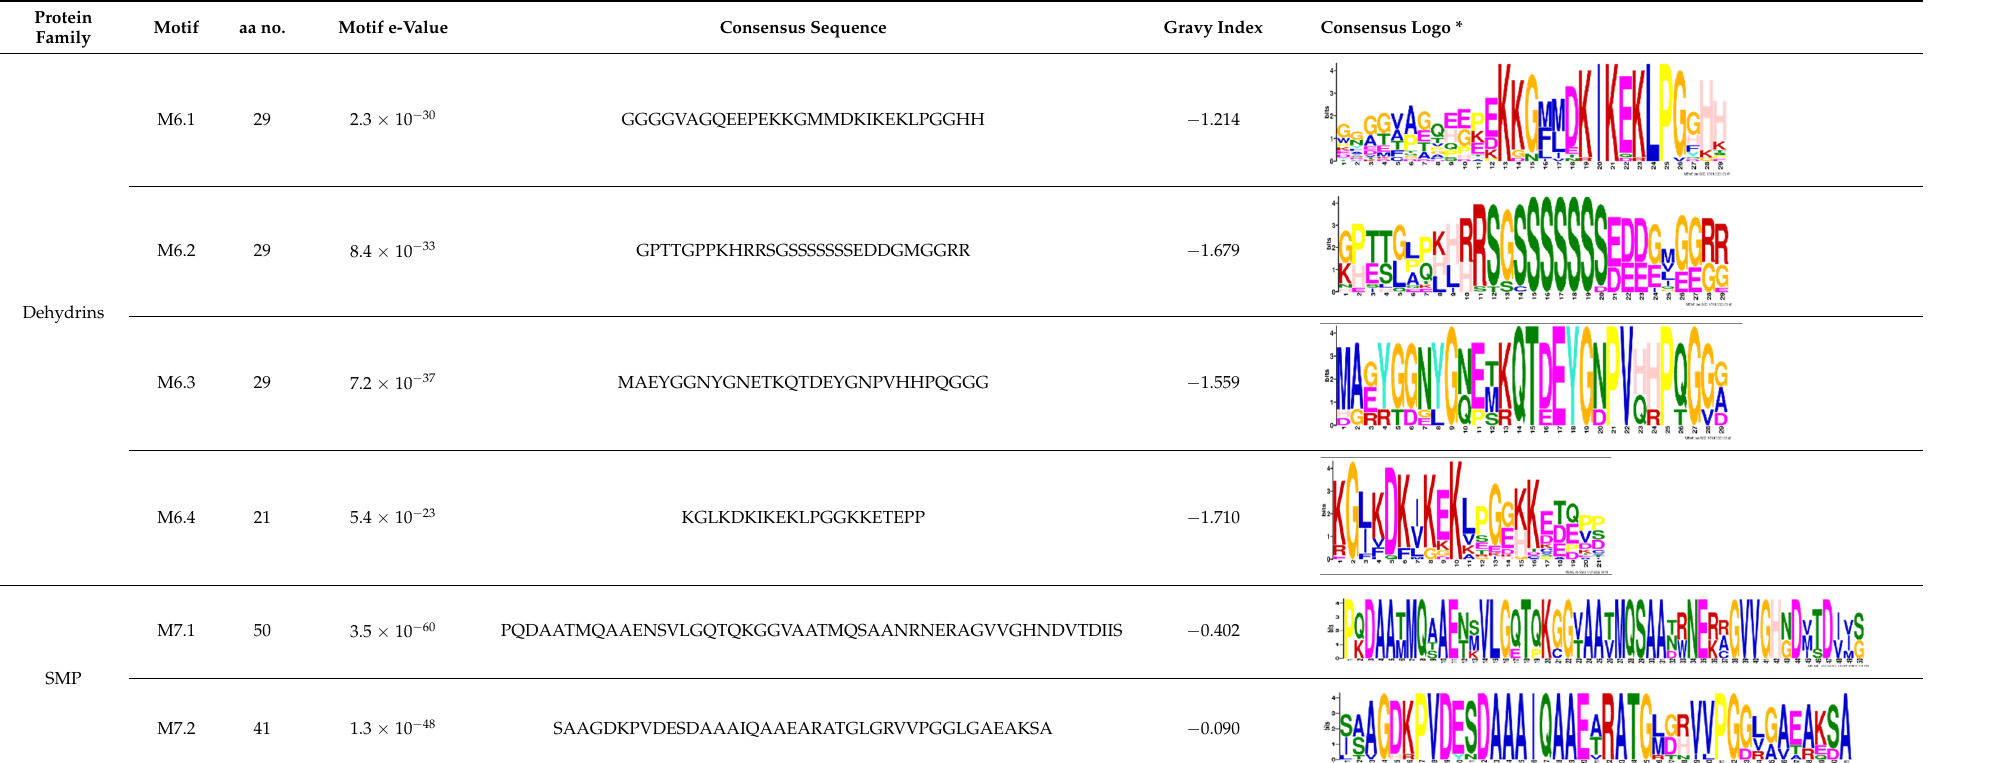
* Different-sized letters in the MEME sequence logos denote the individual residue probabilities. Important motif components are bolded. The colour scheme of the logo indicates the amino acid types: polar uncharged, green; positively charged, red; negatively charged, pink; nonpolar, blue; Gly, orange, Pro, yellow; His, light pink; Tyr, cyan.